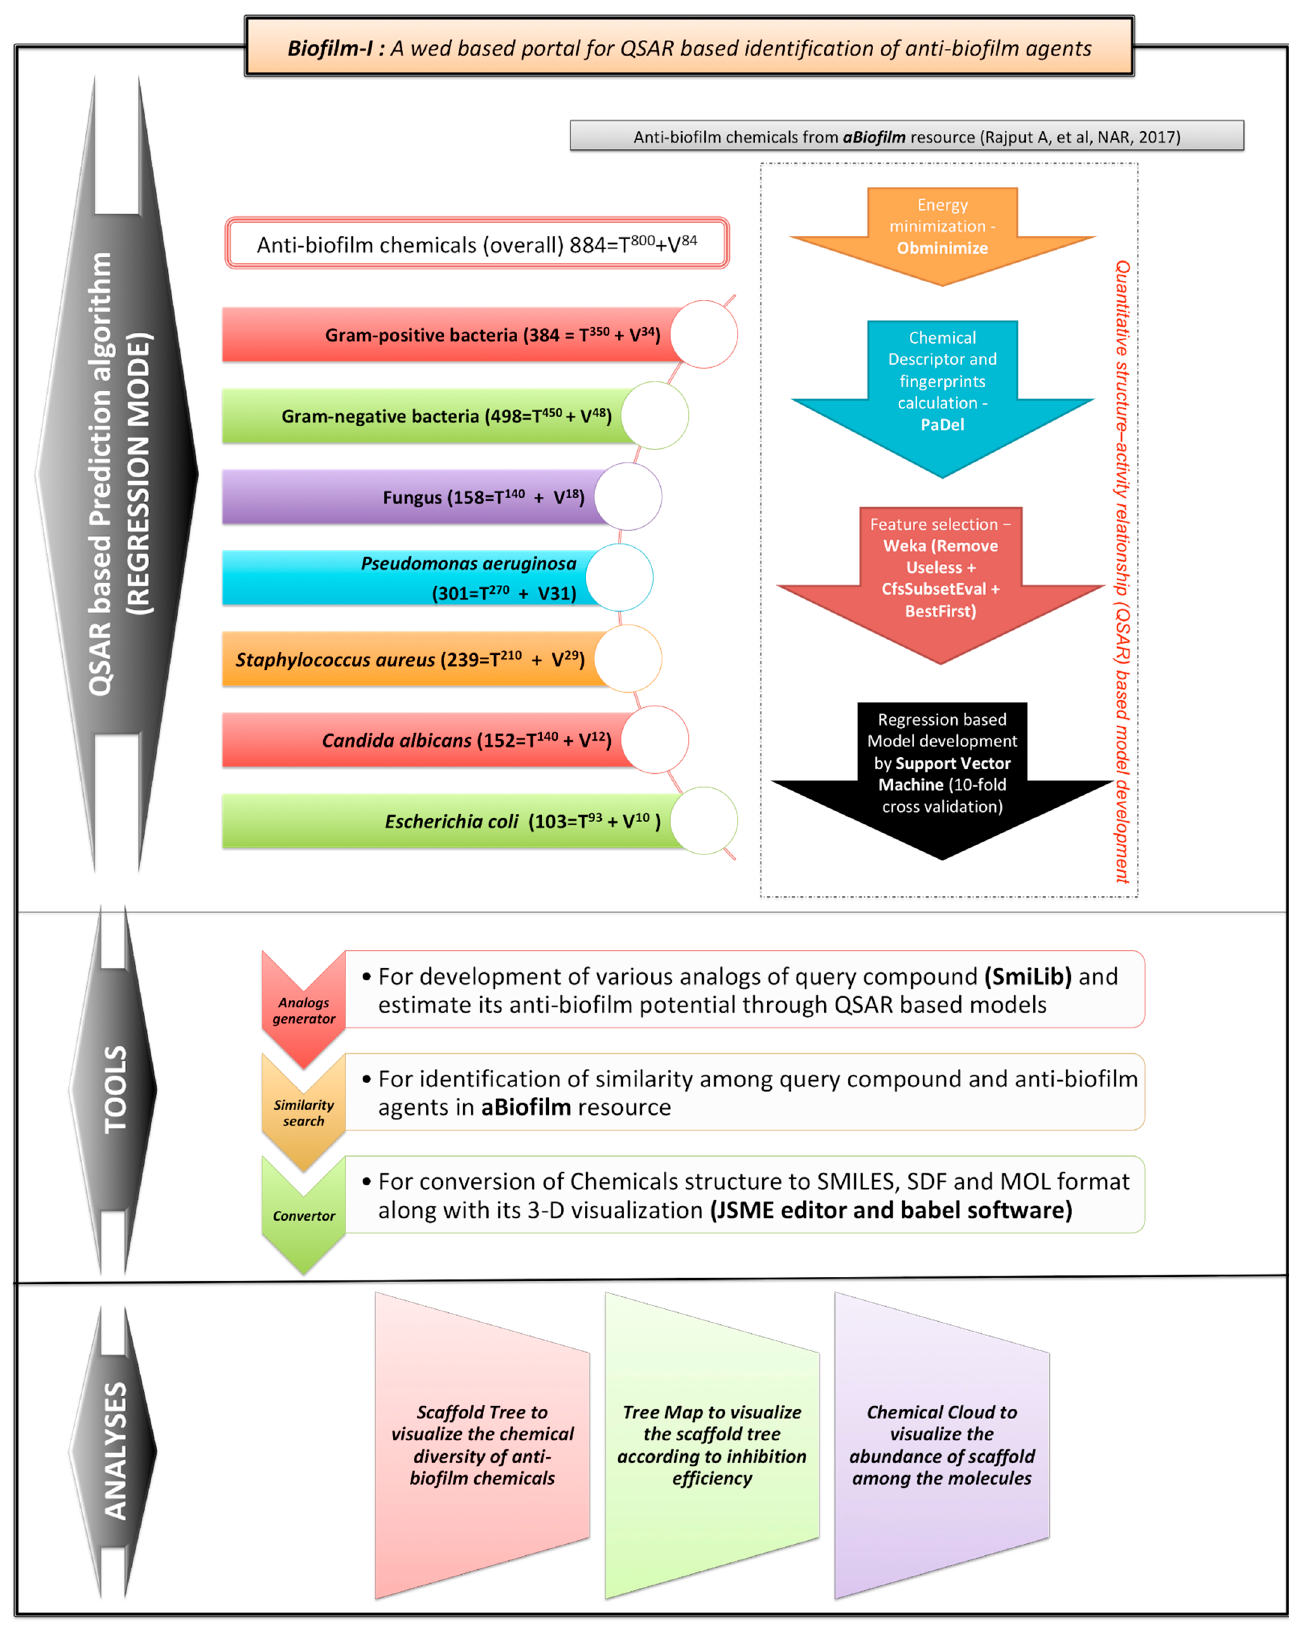
Figure 2. The overall architecture of the biofilm- i web portal. The overall architecture of the biofilm-i web portal. The data was taken from aBiofilm resource